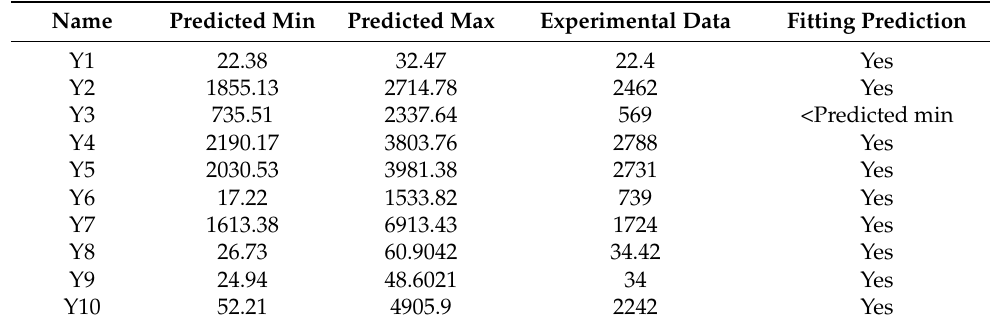
Table 7. Experimental data vs. predicted minimum and maximum values.